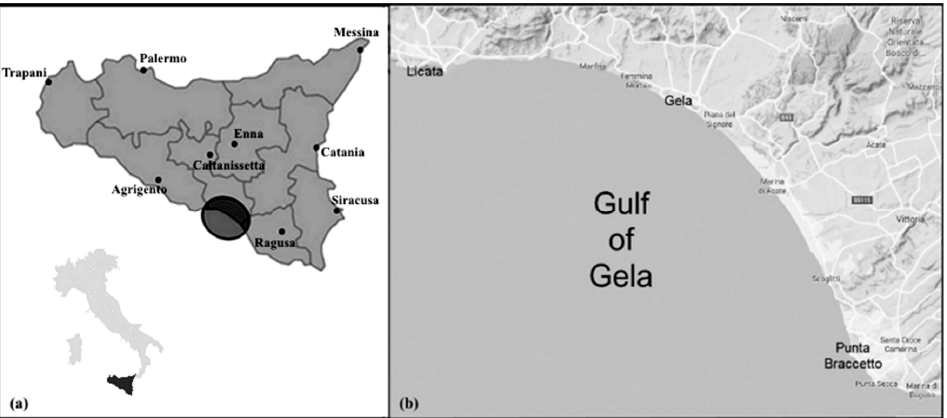
Figure 1. Location of ( a ) Gela area in Sicily (Italy) and ( b ) study area of Gela and municipalities of the high environmental risk area.